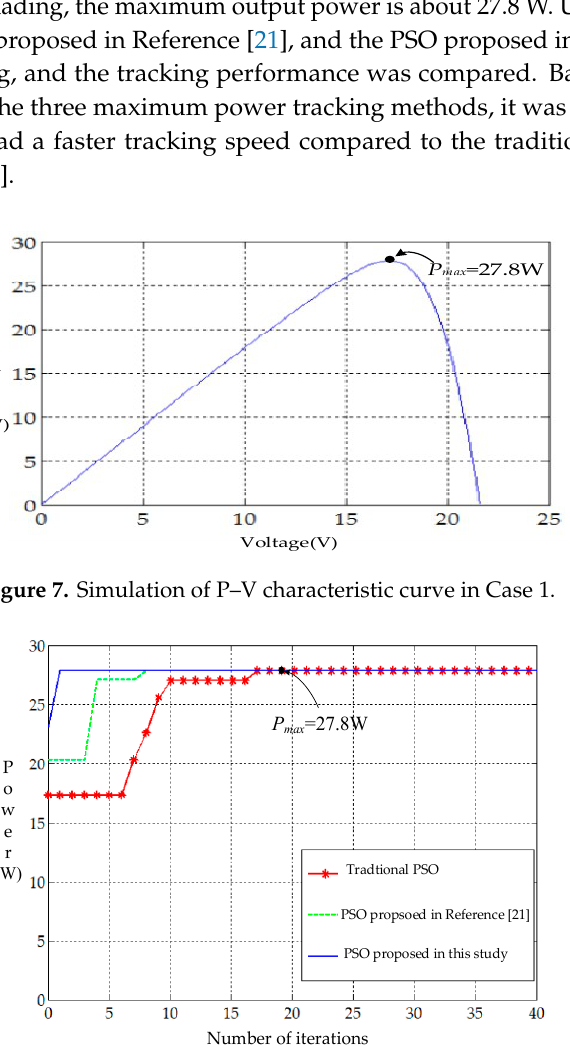
Figure 8. Comparison reuslts of maximum power tracking in Case 1 using the traditional PSO, the improved PSO in Reference [21], and the PSO proposed in this study.